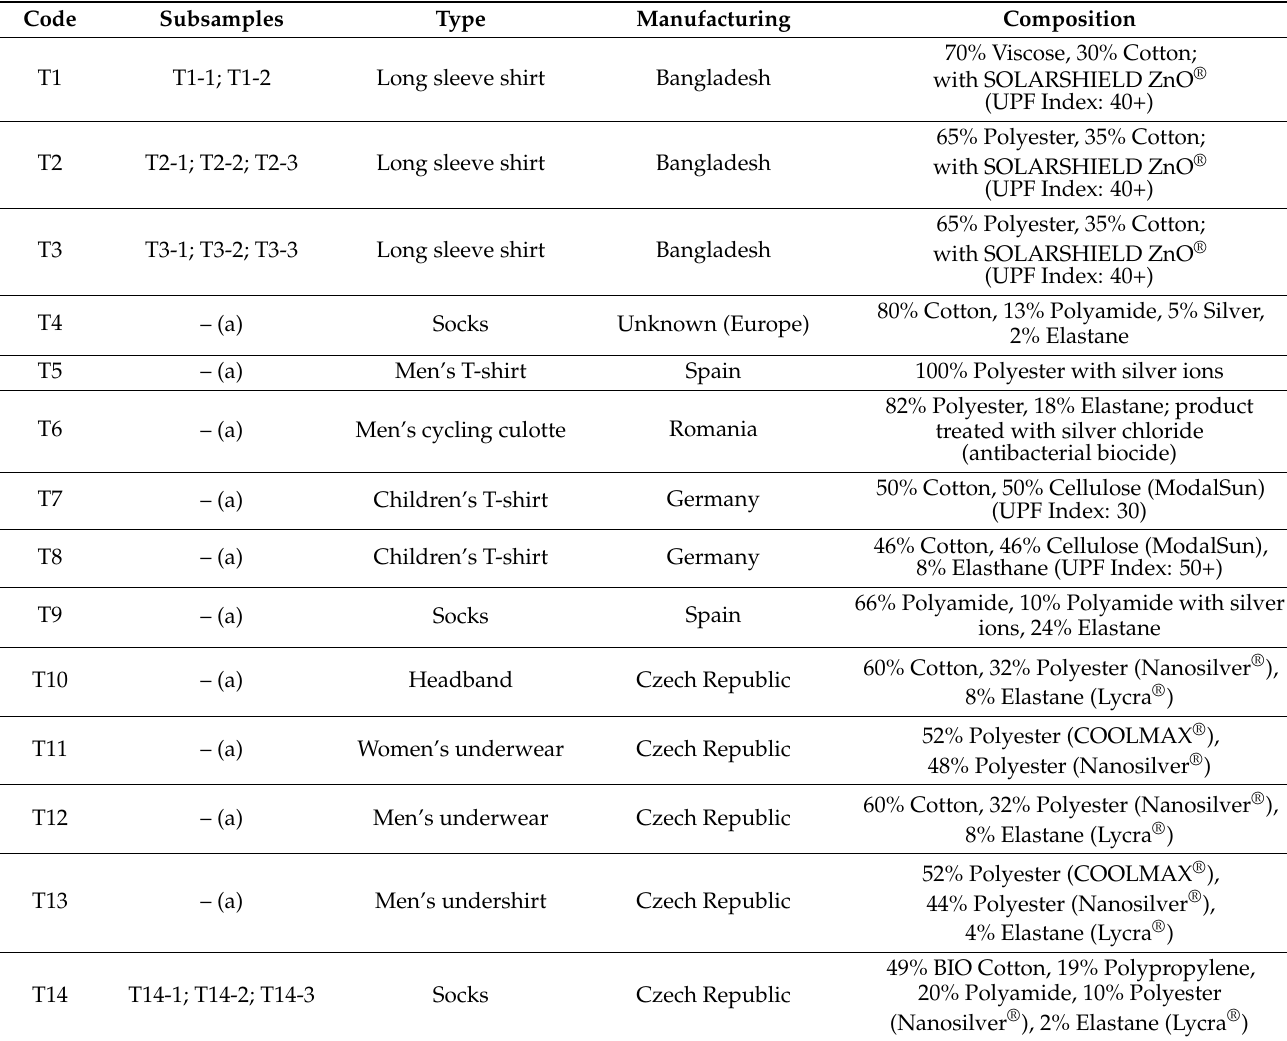
Table 1. Type of item, number of subsamples, and composition of studied